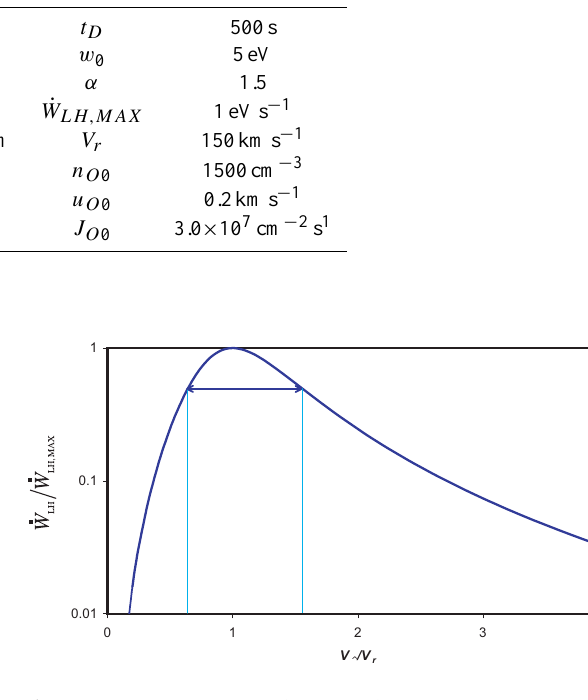
Fig. 12. LH heating rate as a function of the perpendicular velocity. The vertical lines correspond to the half-band width of the